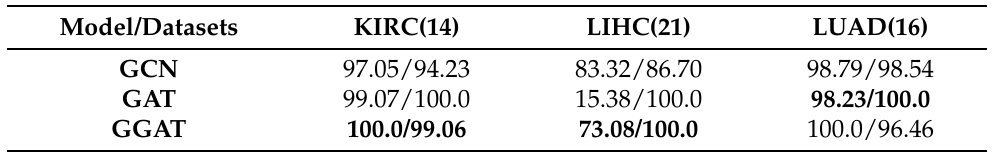
Table 6. Sensitivity vs. Specificity (TPR vs. TNR, %) of three Graph Convolution Models Under Optimal Feature Dimensions.